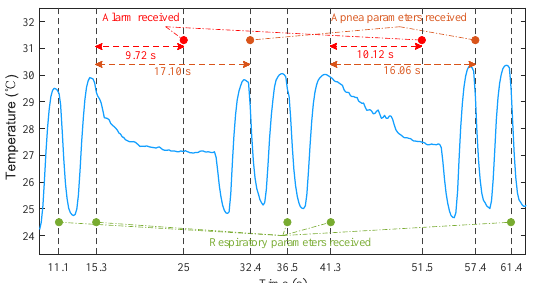
Figure 20. The example of apnea detection process.